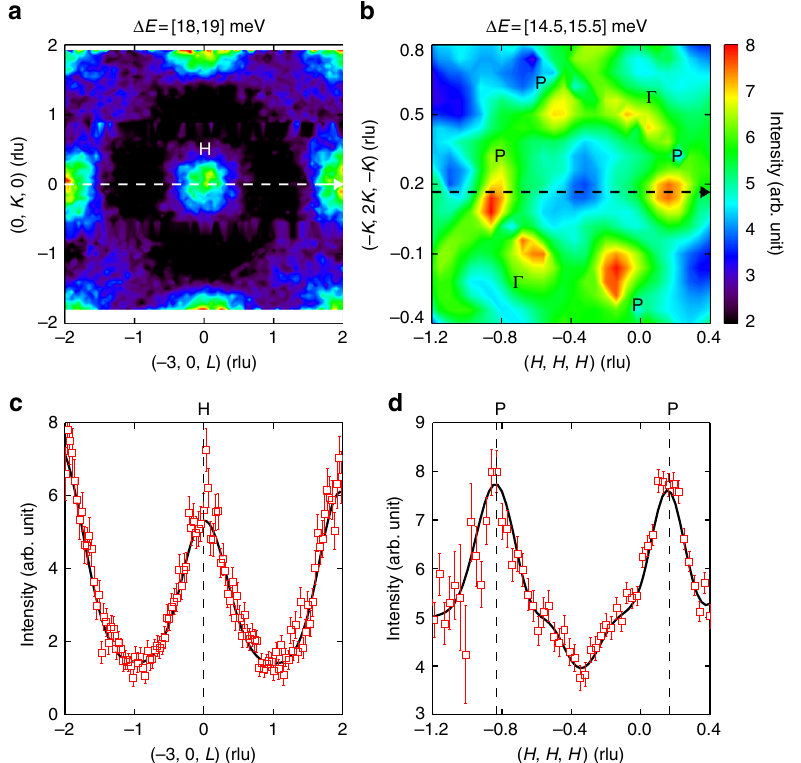
Fig. 3 Triply degenerate and Dirac nodes. a Contours plotted against two orthogonal axes [010] and [001] with an energy interval of 18.5 ± 0.5 meV, and b against [111] and ½ (cid:1) 12 (cid:1) 1 (cid:2) with an energy interval of 15 ± 0.5 meV. Dashed arrows in a , b indicate the trajectories of the cuts plotted in c , d . Vertical dashed lines in c , d denote the triply degenerate and Dirac nodes, respectively. Lines through data are fi ts with Gaussian functions. Errors represent one standard deviation throughout the